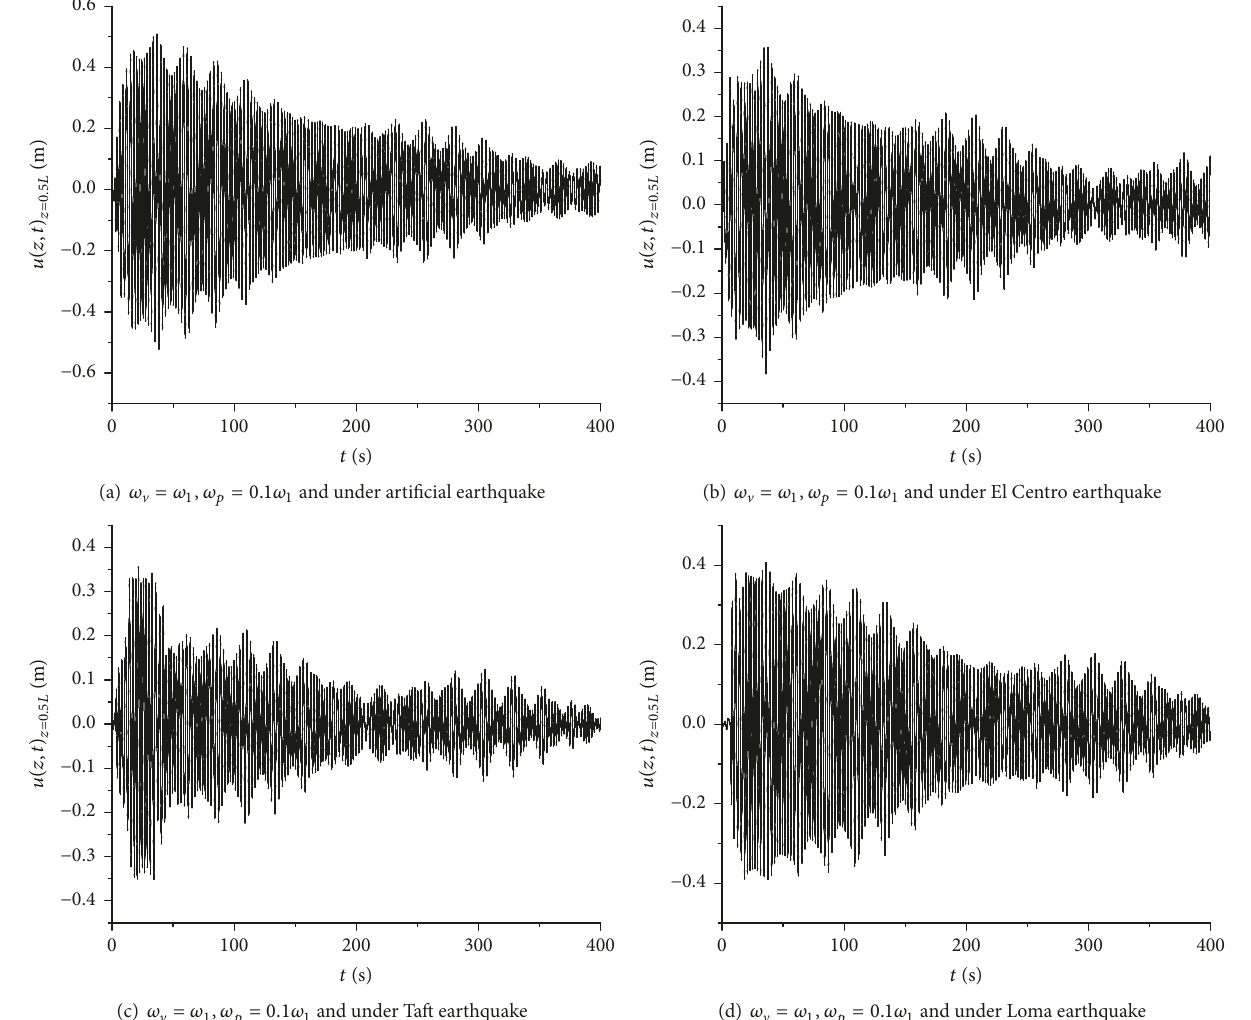
Figure 11: Comparison of dynamic responses of the cable between the cases of four site classifications earthquakes.